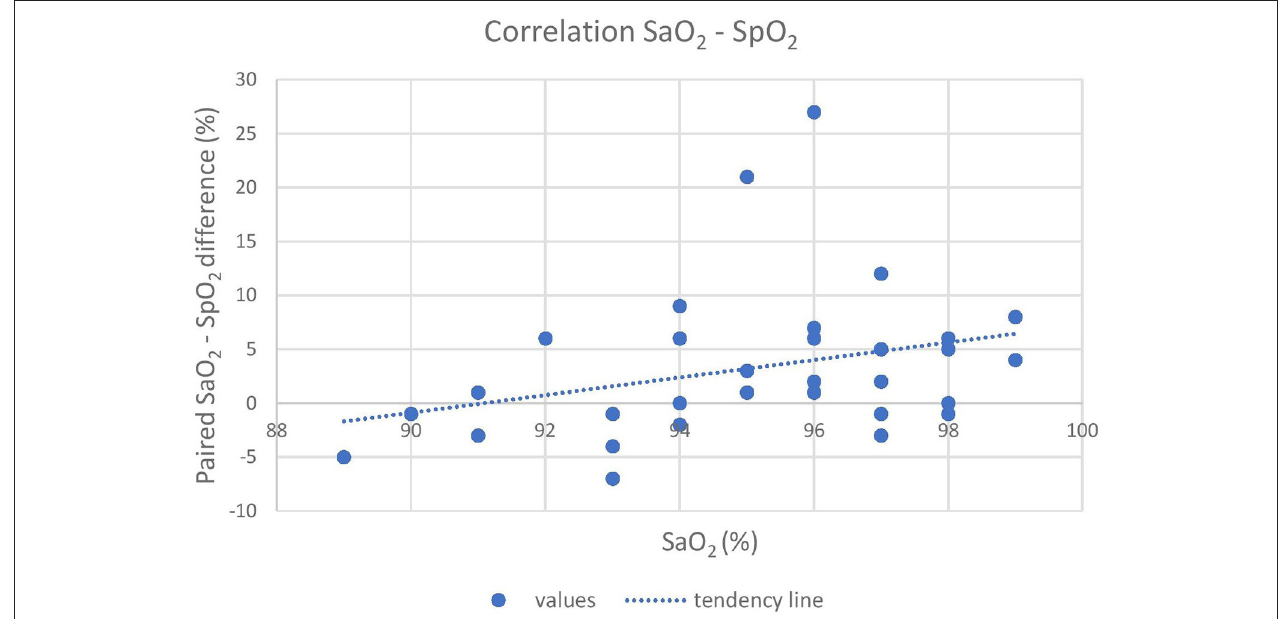
FIGURE 3 | The graph shows the poor correlation between the pulse-oximeter and the iSTAT (X-axis) results. The difference between SaO 2 , and SpO 2 is reported on the Y-axis. A tendency of the pulse-oximeter to underestimate actual SaO 2 , especially at high readings, is shown. SaO 2 , arterial oxyhemoglobin saturation; SpO 2 , peripheral oxyhemoglobin saturation.